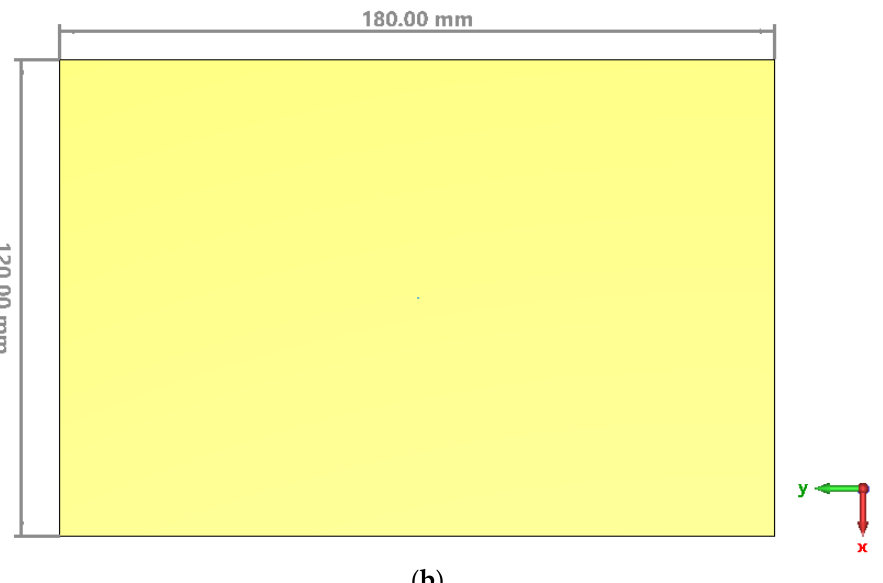
Figure 13. Full simulation model of the meander line monopole antenna: ( a ) Side view; ( b ) Top view — ground plane.